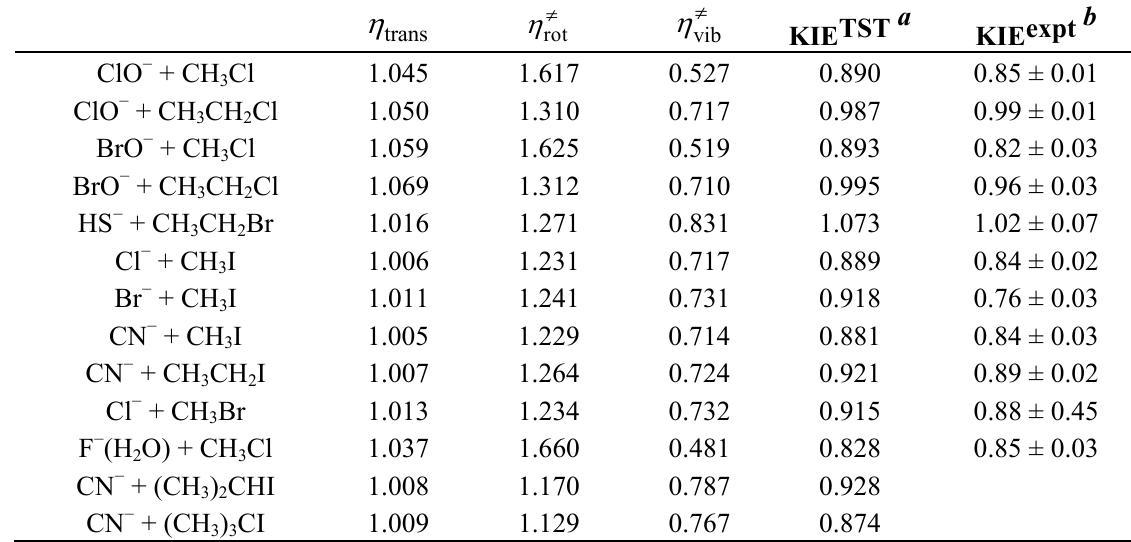
Table 5. Calculated translational, rotational, and vibrational contributions to the deuterium KIEs at 300 K. trans